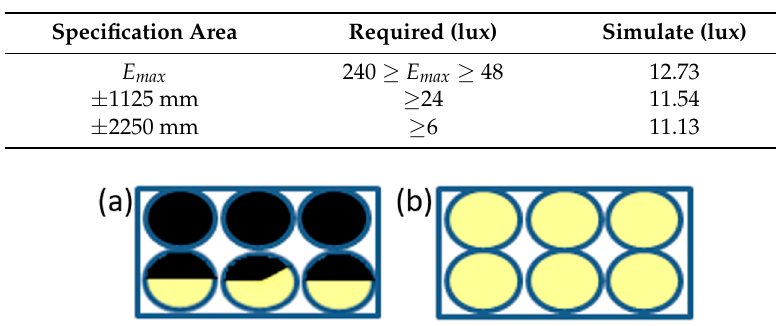
Figure 4. ( a ) Width of the light field on the work plane in low beam mode, ( b ) conceptual design of the low beam system, ( c ) diagram of the light field of the low beam system, and ( d ) diagram of the light field of the high beam system. Table 4. Comparison of simulated results and illuminance regulations of the light field in high beam mode.